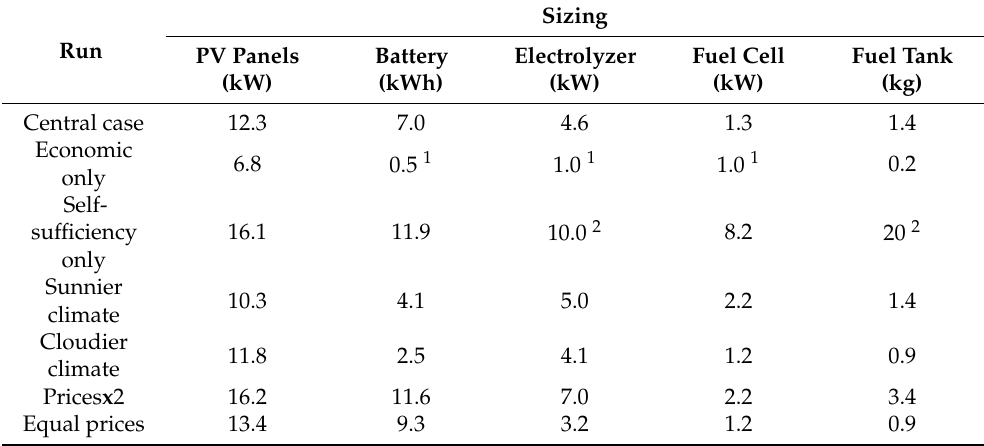
Table 4. Result of the